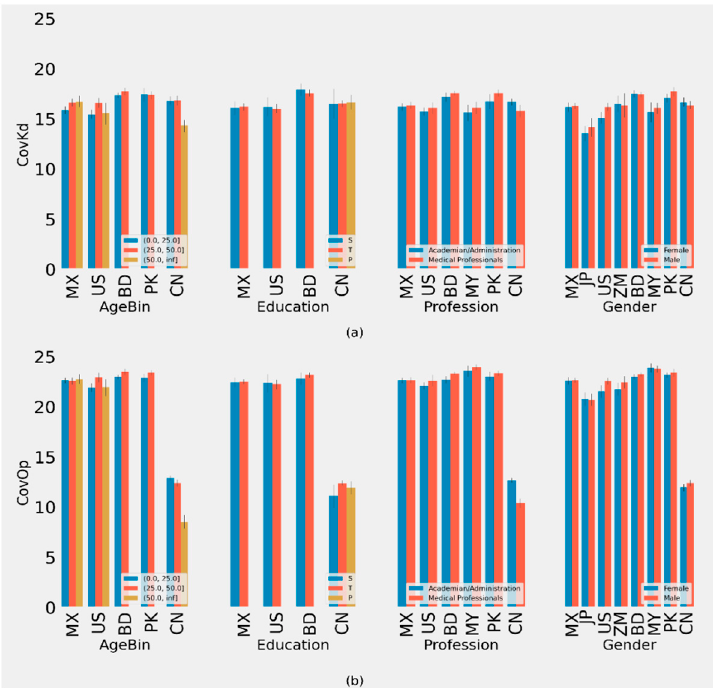
Figure 2. ( a ) Plot of Average CovIA metric of different groups with 90% CI. ( b ) Plot of Average CovOp metric of different groups with 90% CI. (ISO-2 Codes for countries are used.)